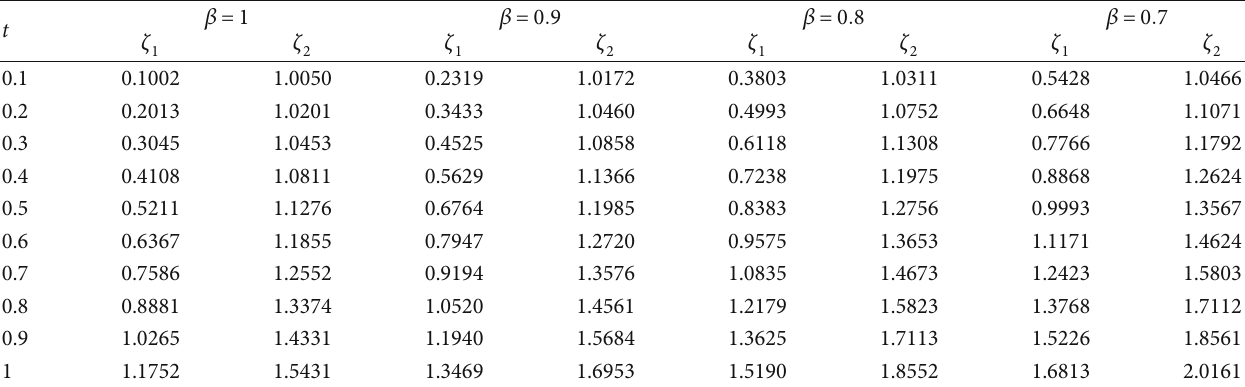
Figure 8: In (a), the numerical solutions corresponding to Problem 4 for fractional-order β for ζ solutions corresponding to Problem 4 for fractional-order β for ζ Table 8: The approximate solutions for various values of β using the CIM numerical schemes for N = 240 , corresponding to example